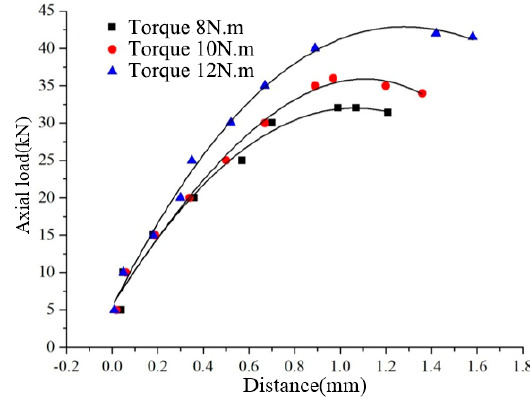
Figure 20. Axial force variation under different torques.